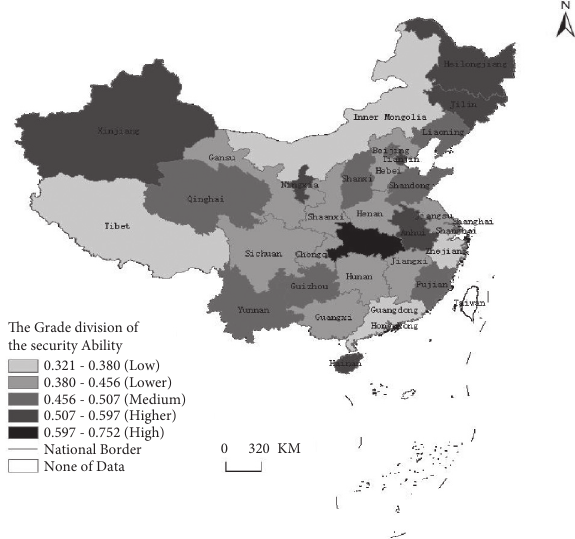
Figure 1: Grade division of the security ability of the EIUR in